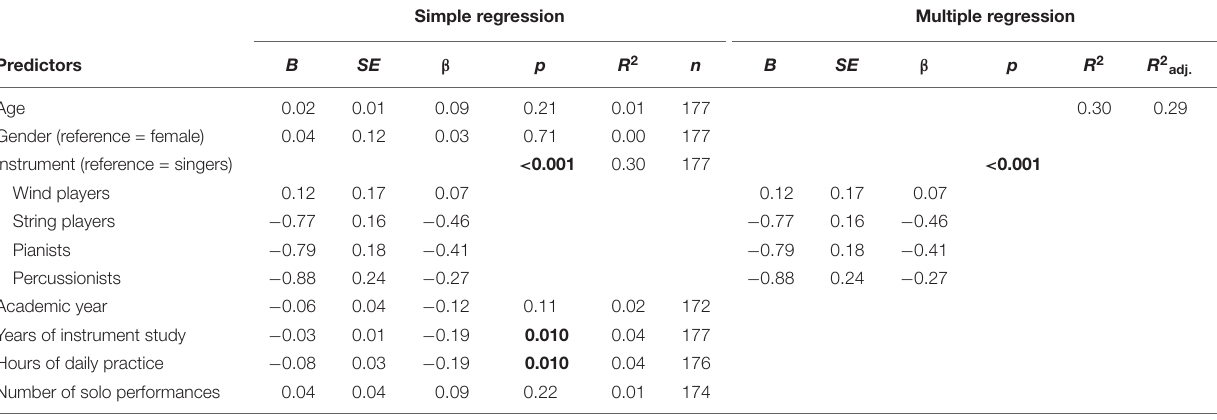
TABLE 6 | Results of the linear regression analyses for mouth- and throat-related complaints. Simple regression